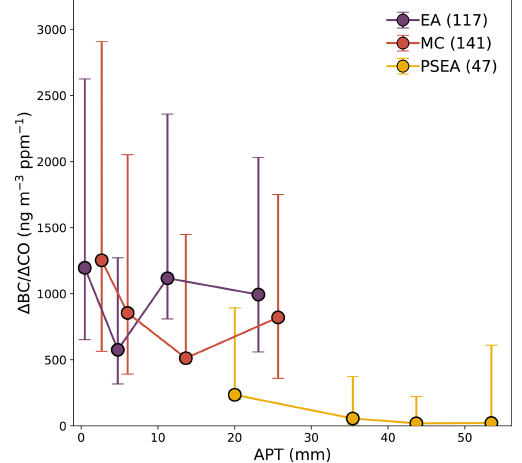
Figure 9. (cid:49) BC /(cid:49) CO ratio ( (cid:49) CO > 0.02ppm) as a function of accumulated precipitation along individual trajectories (APT) re- solved by source region. APT was calculated with PERSIANN- CDR. Medians and 25th/75th percentiles (error bars) are shown for each source region: peninsular Southeast Asia (PSEA), the Mar- itime Continent (MC), and East Asia (EA). The West Pacific (WP) was not plotted because of few data points where (cid:49) CO > 0.02ppm. The number of observations plotted per source region is provided in